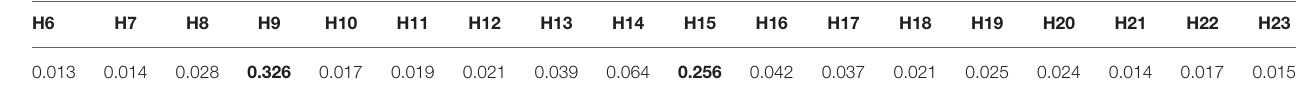
TABLE 3 | Input feature importance returned by